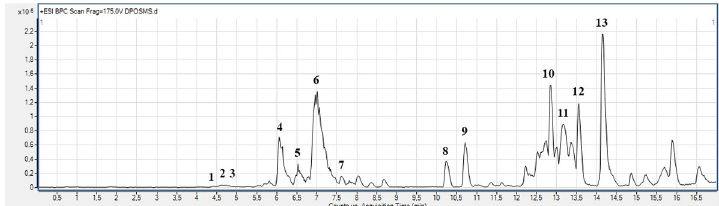
Fig 1. Chromatogram of the alkaloid and acetogenin-rich fraction from Annona crassiflora fruit peel (AF-Ac) by HPLC-ESI-MS/MS (positive mode).